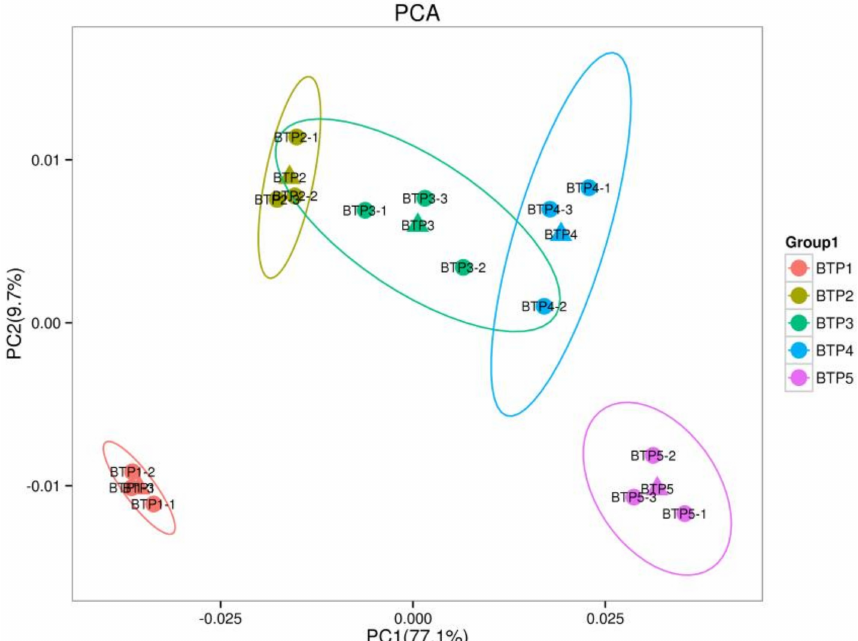
Figure 1. PCA scores plot of different floral development stages by UPLC-ESI-MS/MS metabolite analysis. PC1, principal component 1; PC2, principal component 2. Explained variants PC1: 77.1%, PC2: